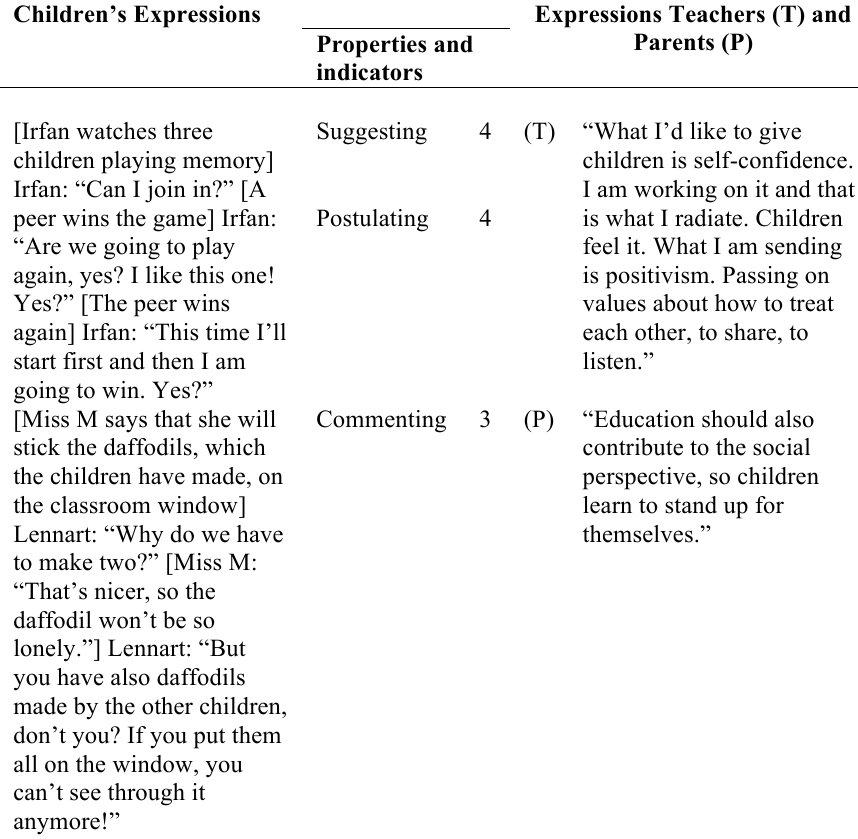
Children’s Expressions Corresponding With a Teacher’s and a Parent’s Expression on Level D Children’s Expressions Expressions Teachers (T)